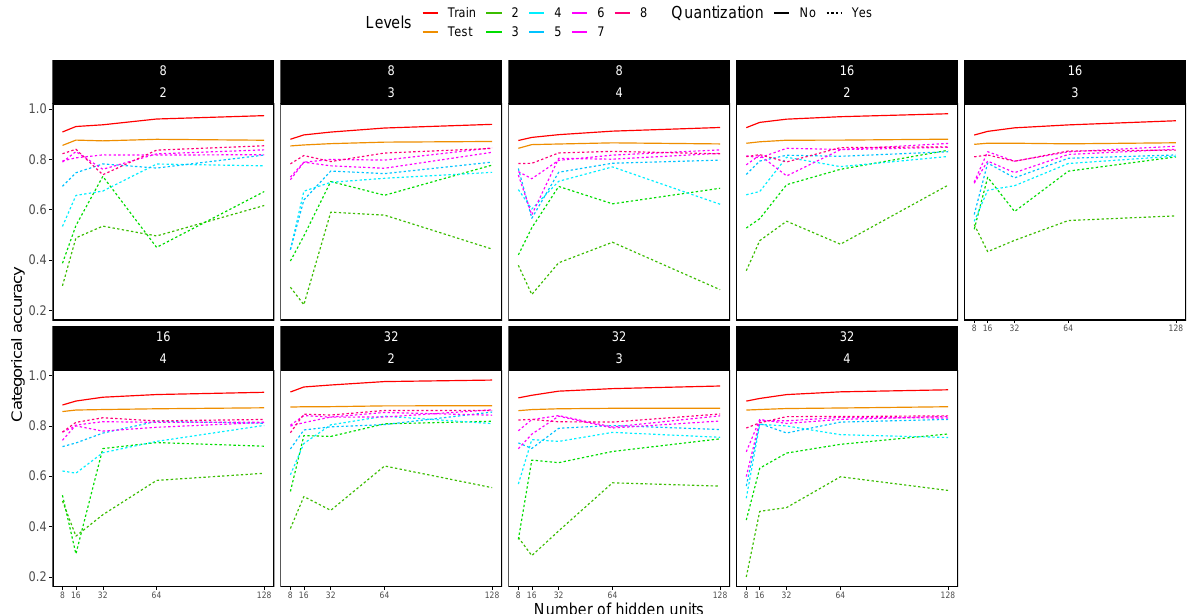
Figure 12. Categorical accuracy for the Fashion MNIST dataset using 1-CNN (i.e., one convolutional layer + one pooling layer). Only one hidden layer was used, with hidden units ranging from 8 to 128 ( x axis). Each dashed line in the plots shows the accuracy for different quantization levels, while solid lines indicate no quantization. Each box in the figure shows a particular experiment: convolutional layer with 8, 16 and 32 filters (top number of the box) and pooling with 2 × 2, 3 × 3 and 4 × 4 matrices (bottom number of the